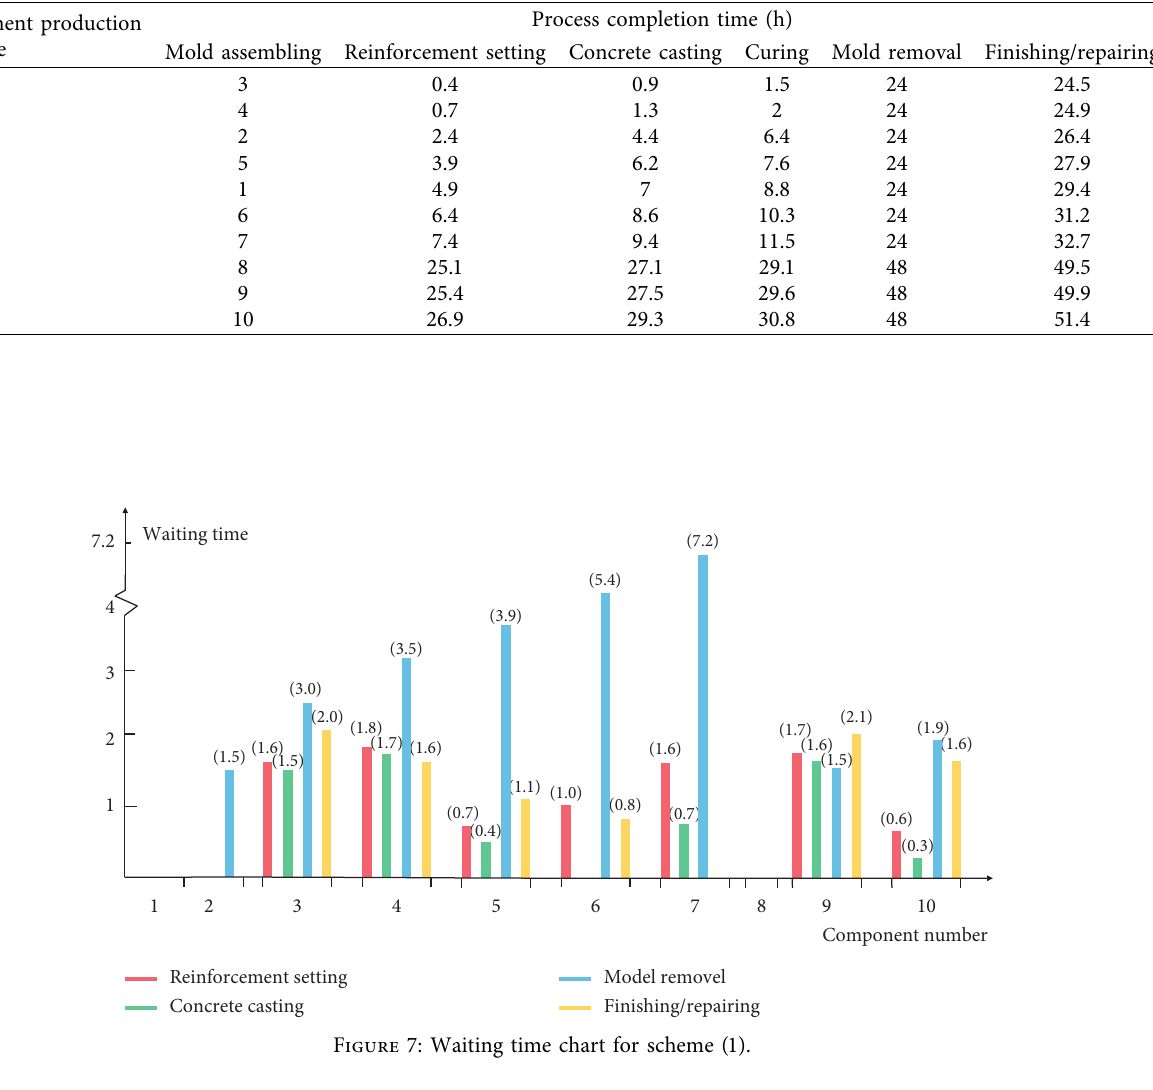
Table 8: Completion time of each process for scheme (2).